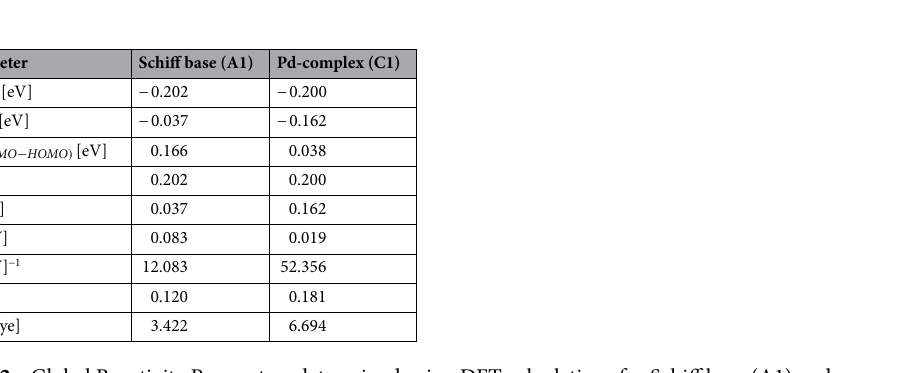
Table 2. Global Reactivity Parameters determined using DFT calculations for Schiff base (A1) and Pd-complex (C1).